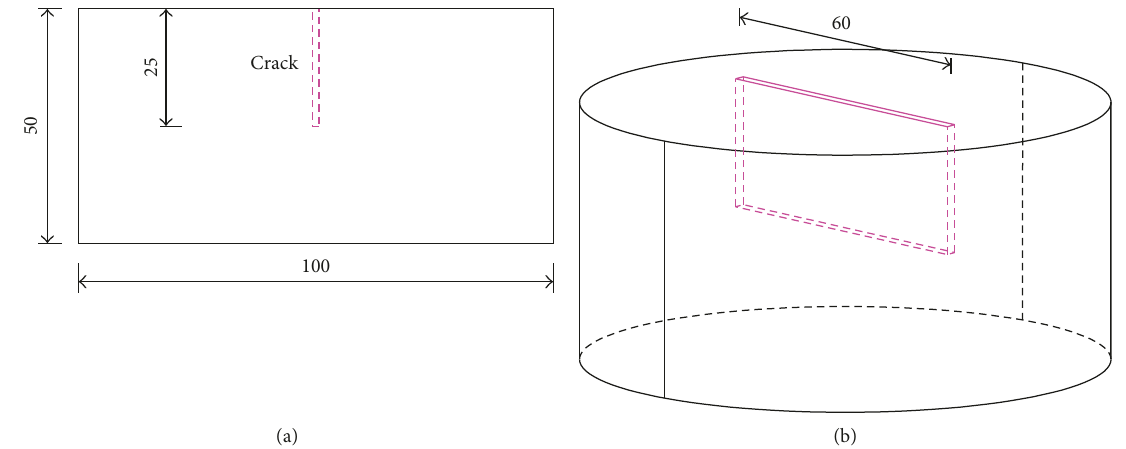
Figure 1: Specimen dimension (unit: mm). (a) Front view. (b) Stereoscopic view.